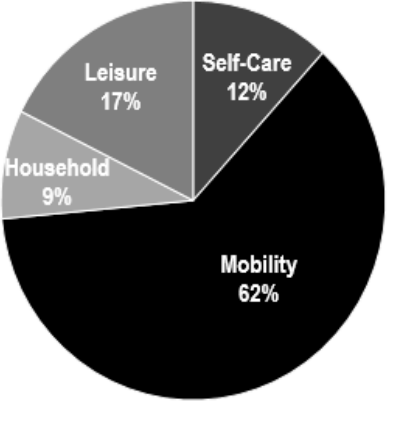
Figure 3. Comparison of participant-identified performance problems by category (n=34) using the